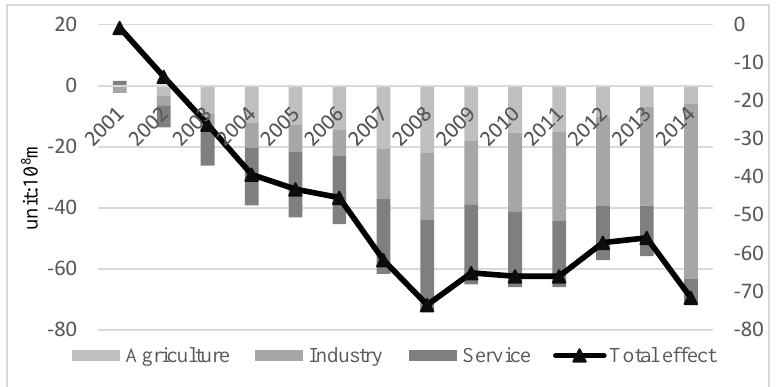
Figure 8. Relationship between industrial structure and water intensity effect.